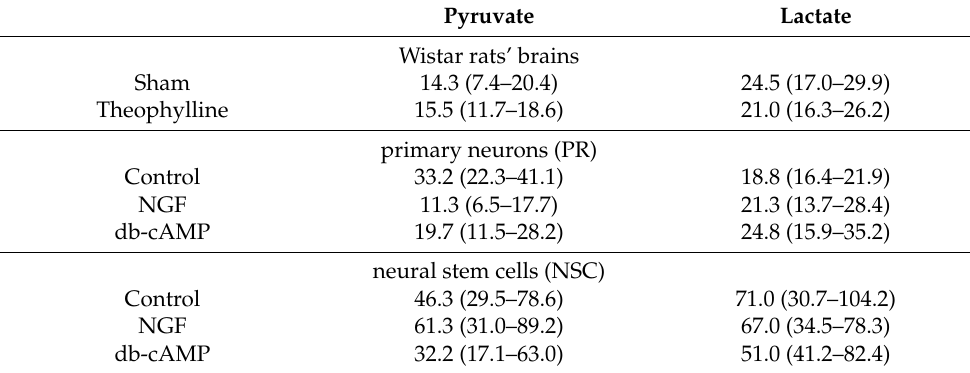
Table 3. Metabolic profile of research